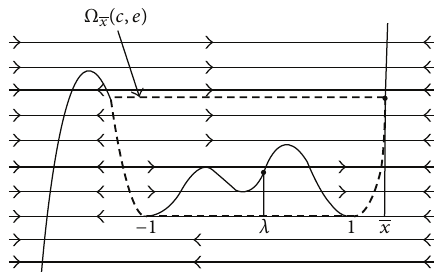
Figure 1: Canard cycle having two jump points.